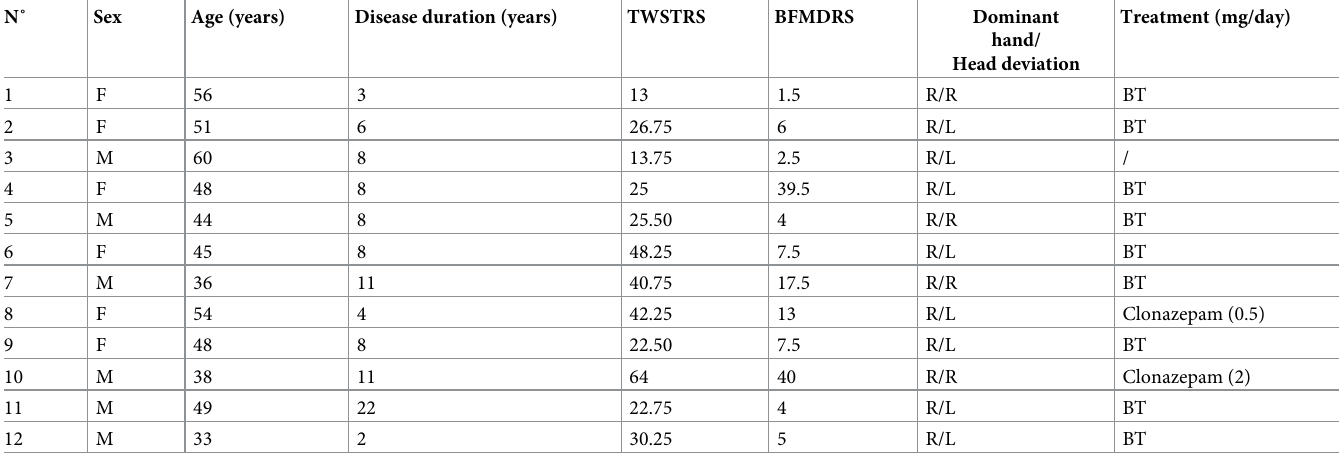
Table 1. Clinical characteristics of patients with cervical dystonia.